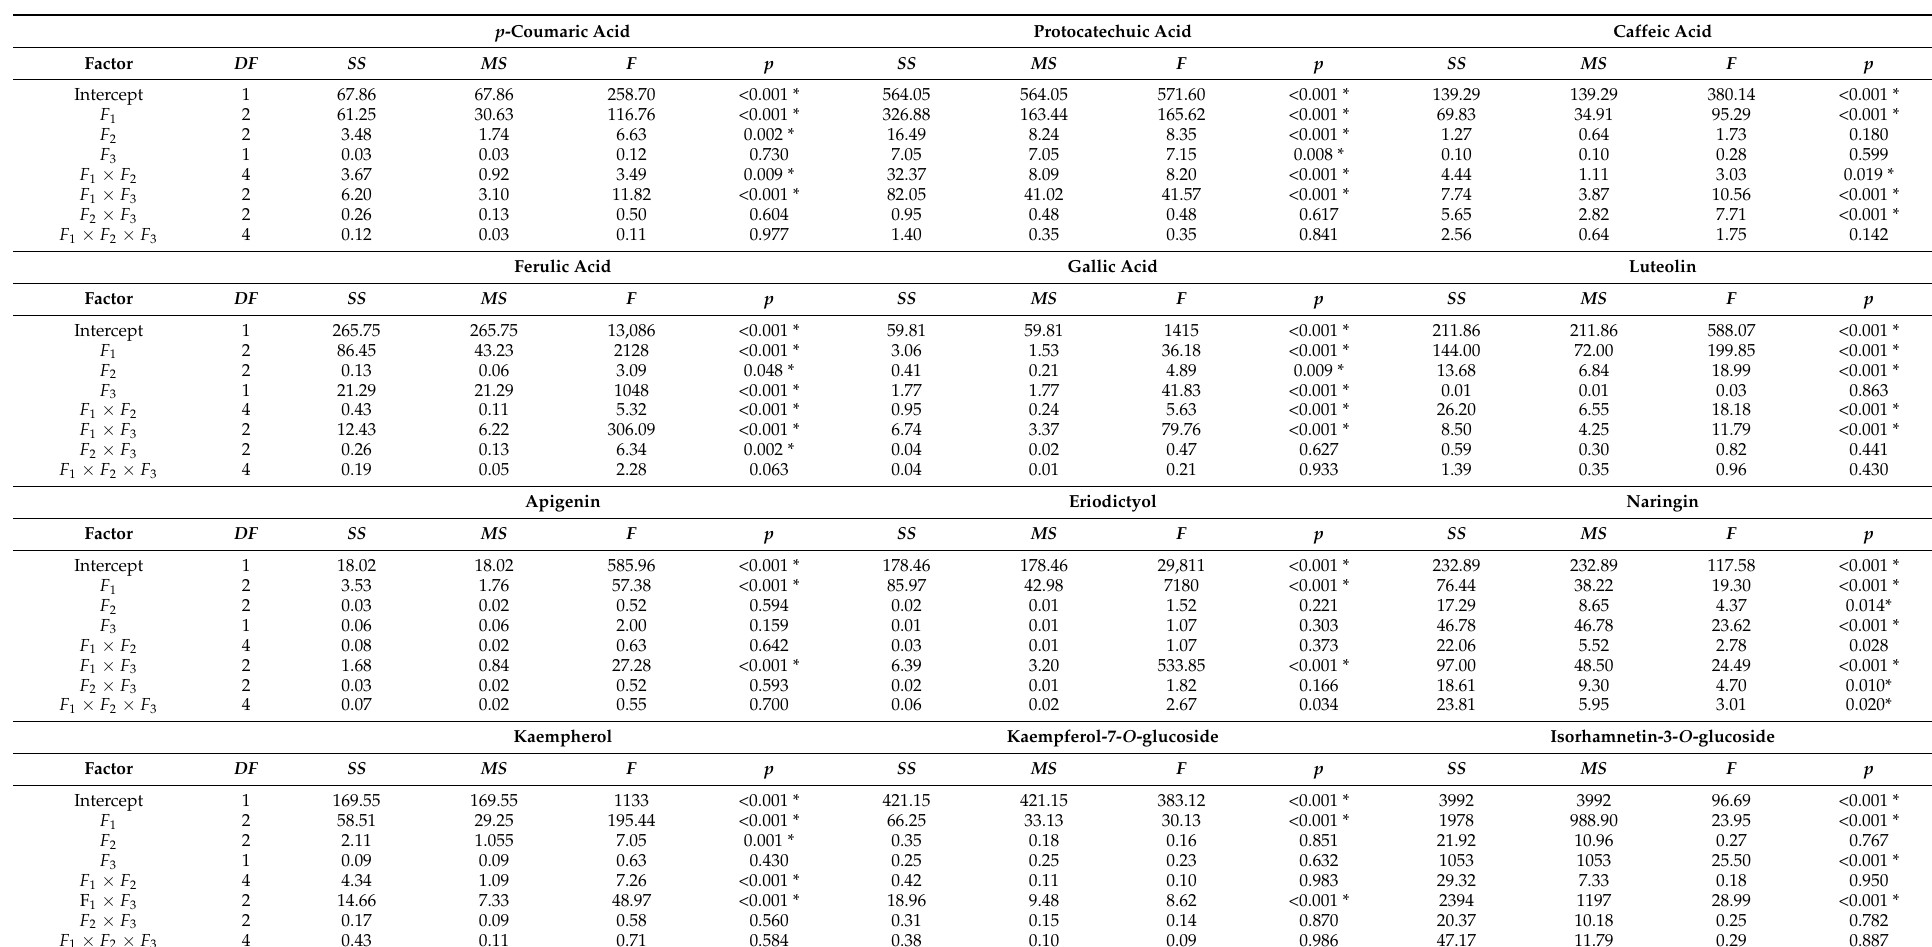
Table 2. Univariate test for the significance of the factor effects influencing the phenolic micro-components level in the analyzed samples. Statistically significant results at p = 0.05 are denoted with